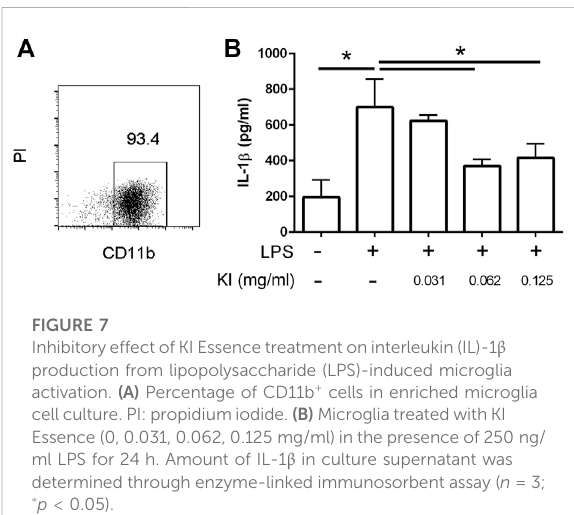
FIGURE 7 Inhibitoryeffect ofKIEssencetreatmentoninterleukin(IL)-1 β production from lipopolysaccharide (LPS)-induced microglia activation. (A) Percentage of CD11b + cells in enriched microglia cell culture. PI: propidiumiodide. (B) Microgliatreated withKI Essence (0, 0.031, 0.062, 0.125 mg/ml) in the presence of 250 ng/ ml LPS for 24 h. Amount of IL-1 β in culture supernatant was determined through enzyme-linked immunosorbent assay ( n = 3; p p <